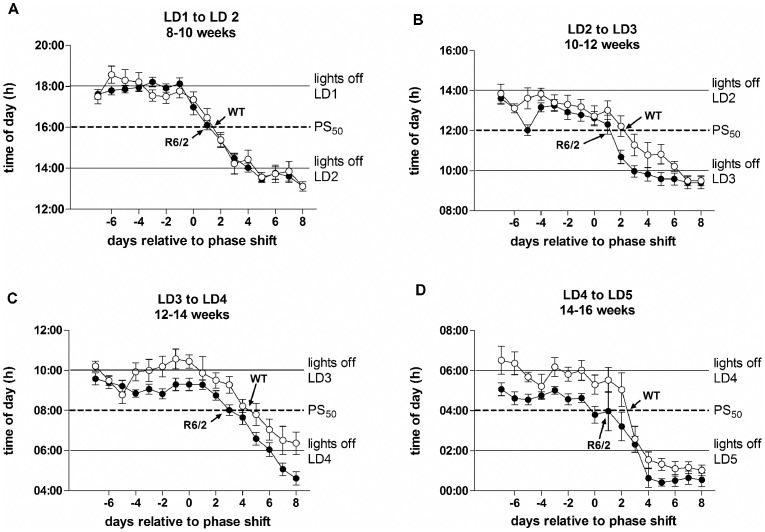
Average time of onset of activity of mice subjected to repeated phase-shifts, showing time to PS50 (the time at which half of the phase-shift was achieved).Light phase-shifts were conducted between 8–10 (A), 10–12 (B), 12–14 (C) and 14–15 (D) weeks of age. All values are means ± SEM. Open symbols are WT mice, filled symbols are R6/2 mice.